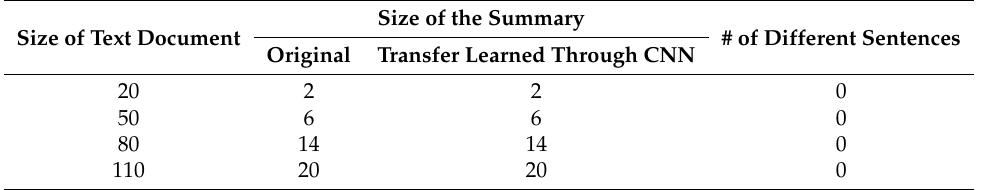
Table 7. Text summarization results of learned embedding